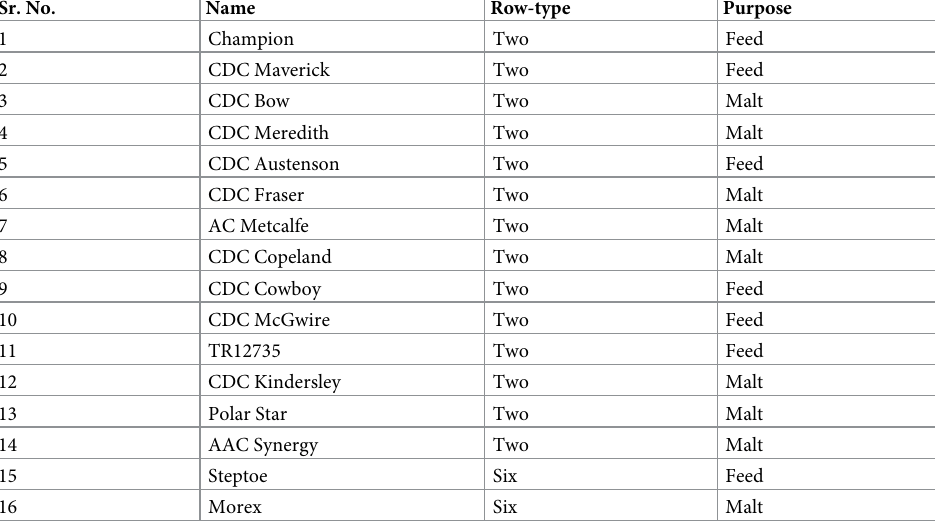
Table 1. List of barley malt and feed varieties. Sr. No. Name Row-type